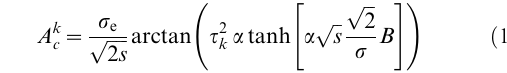
treated area, under which the drug-resistant parasites cannot invade, we use a low-migration approximation as in the previous section.